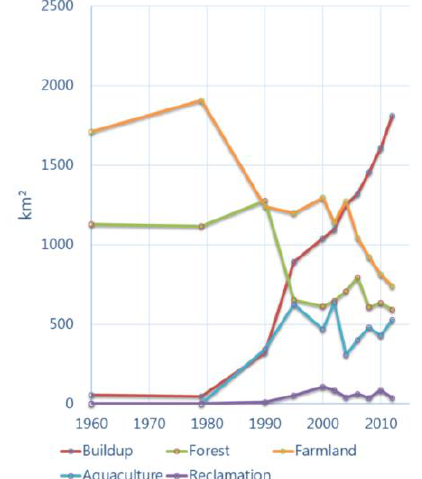
Figure 5. Statistics of landuse change in the